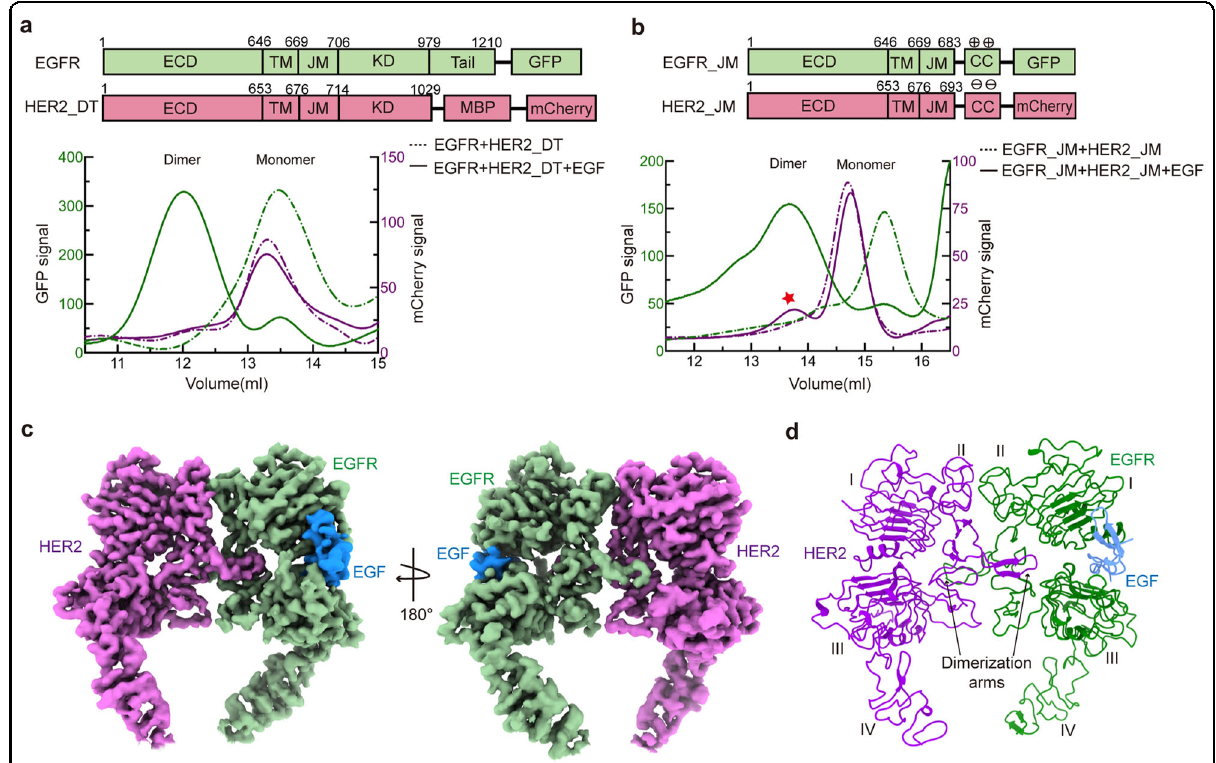
Fig. 1 Cryo-EM structure of the EGF-bound EGFR/HER2 ectodomain complex. a , b Detection of the EGFR/HER2 dimer using FSEC. GFP- and mCherry-tags are attached to the C-termini of EGFR and HER2, respectively. HER2_DT is the tail-deleted form with a substituted MBP-tag. EGFR_JM and HER2_JM constructs only contain the ectodomain, transmembrane domain, part of the juxtamembrane domain, and the coiled-coil (CC) peptide. The basic and acidic CC peptides are attached to EGFR_JM and HER2_JM, respectively. The red pentagram in b indicates the peak position of EGFR_JM/HER2_JM dimer. c Cryo-EM map of the EGF-bound EGFR/HER2 ectodomain complex shown in two views. EGFR, EGF, and HER2 are colored in green, marine, and magenta, respectively. d Overall structure of the EGF-bound EGFR/HER2 heterodimer in ribbon presentation. The color code is the same as that in c . The four domains of EGFR and HER2 ectodomains are indicated with Roman numerals. The DAs of Domain II are also